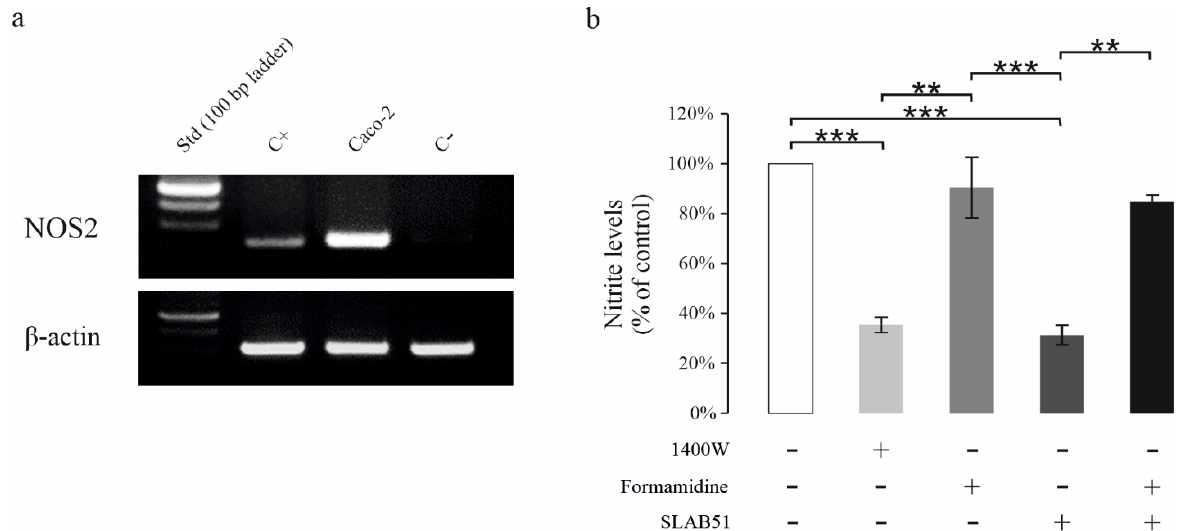
Figure 4. Effect of SLAB51 on NO production in CaCo-2 cells. CaCo-2 cells basically expressed high levels of NOS2 as shown in the representative RT-PCR ( a ). C+: positive control (RAW cells stimulated with IFN- γ + LPS); C- = negative control (Jurkat cells). Nitrite levels were determined in the supernatants from CaCo-2 cells treated for 24 h ( b ) with or without NOS2 inhibitor 1400 W (100 μ M), ADI inhibitor formamidine (10 mM) or SLAB51 (10 7 CFU) preincubated for 30 min with or without formamidine. Values are expressed as percentage of nitrite levels vs. control (mean ± SD). For comparative analysis of data groups, the Kruskal–Wallis test followed by Dunn’s post hoc test was used (* p < 0.05, ** p < 0.01, *** p < 0.001).